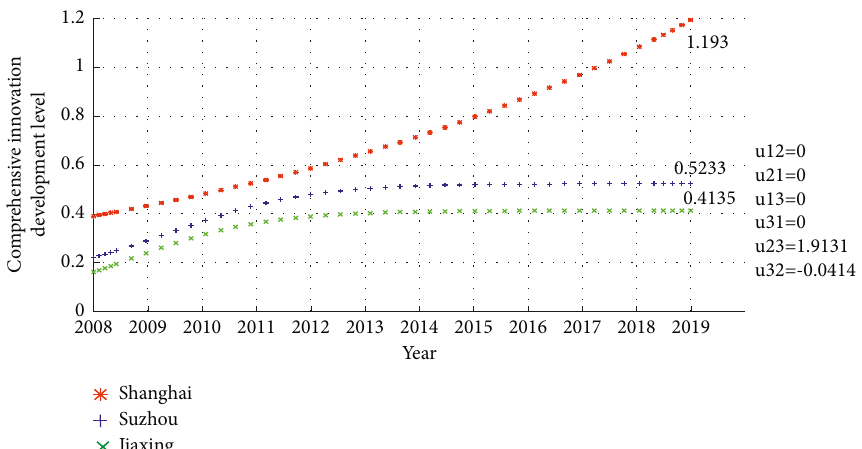
Figure 6: Evolution trend of comprehensive innovation development level under independent symbiosis.